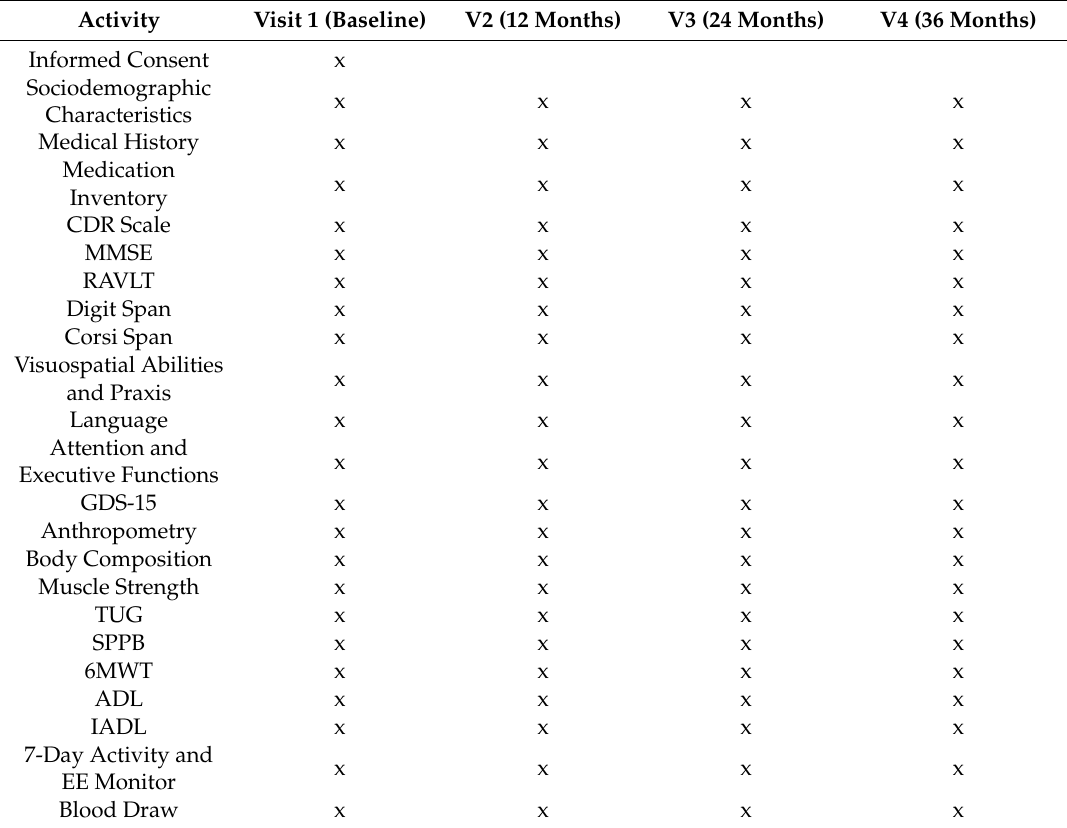
Table 1. Visit schedule and related